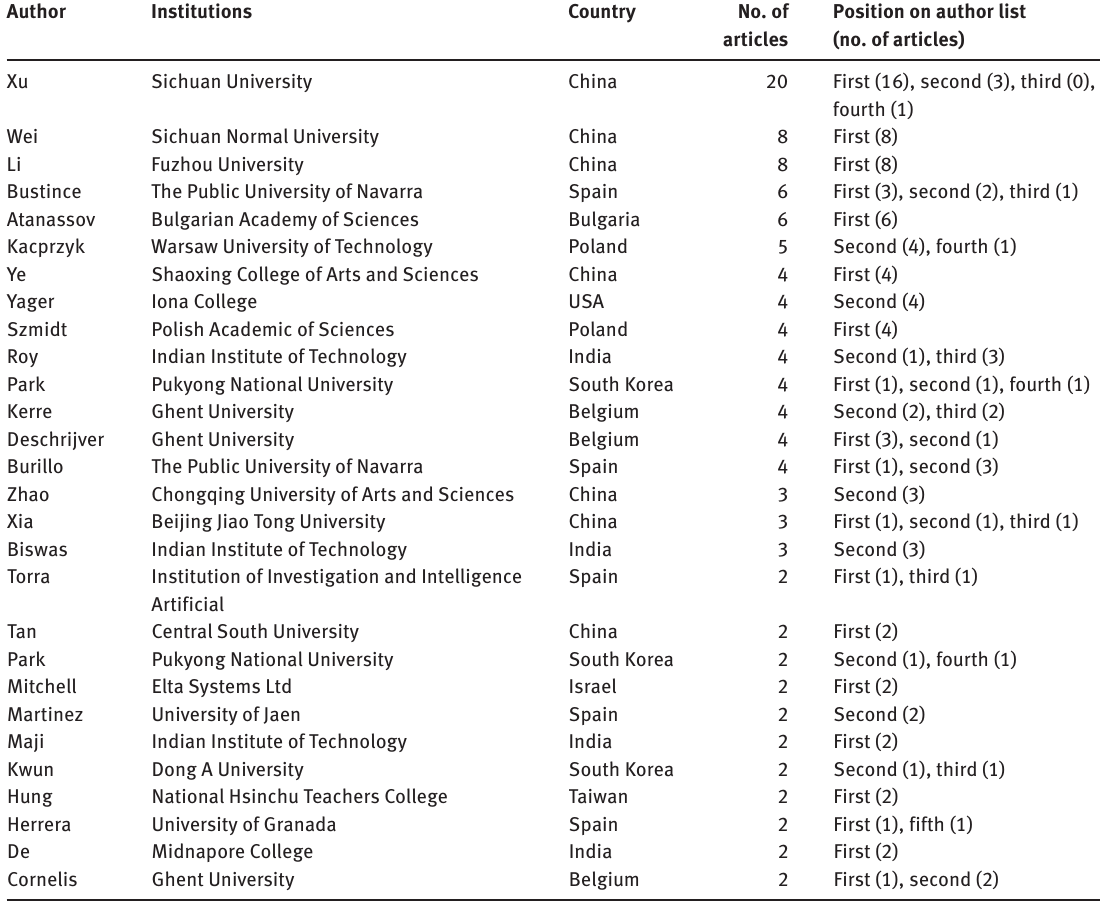
Table 5: Authors Who Contributed ≥ 2 of the 100 Most Cited IFS Articles.